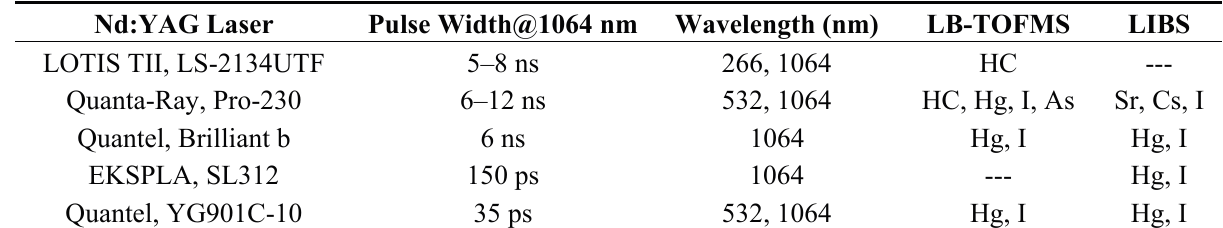
Table 2. Nd:YAG lasers and the